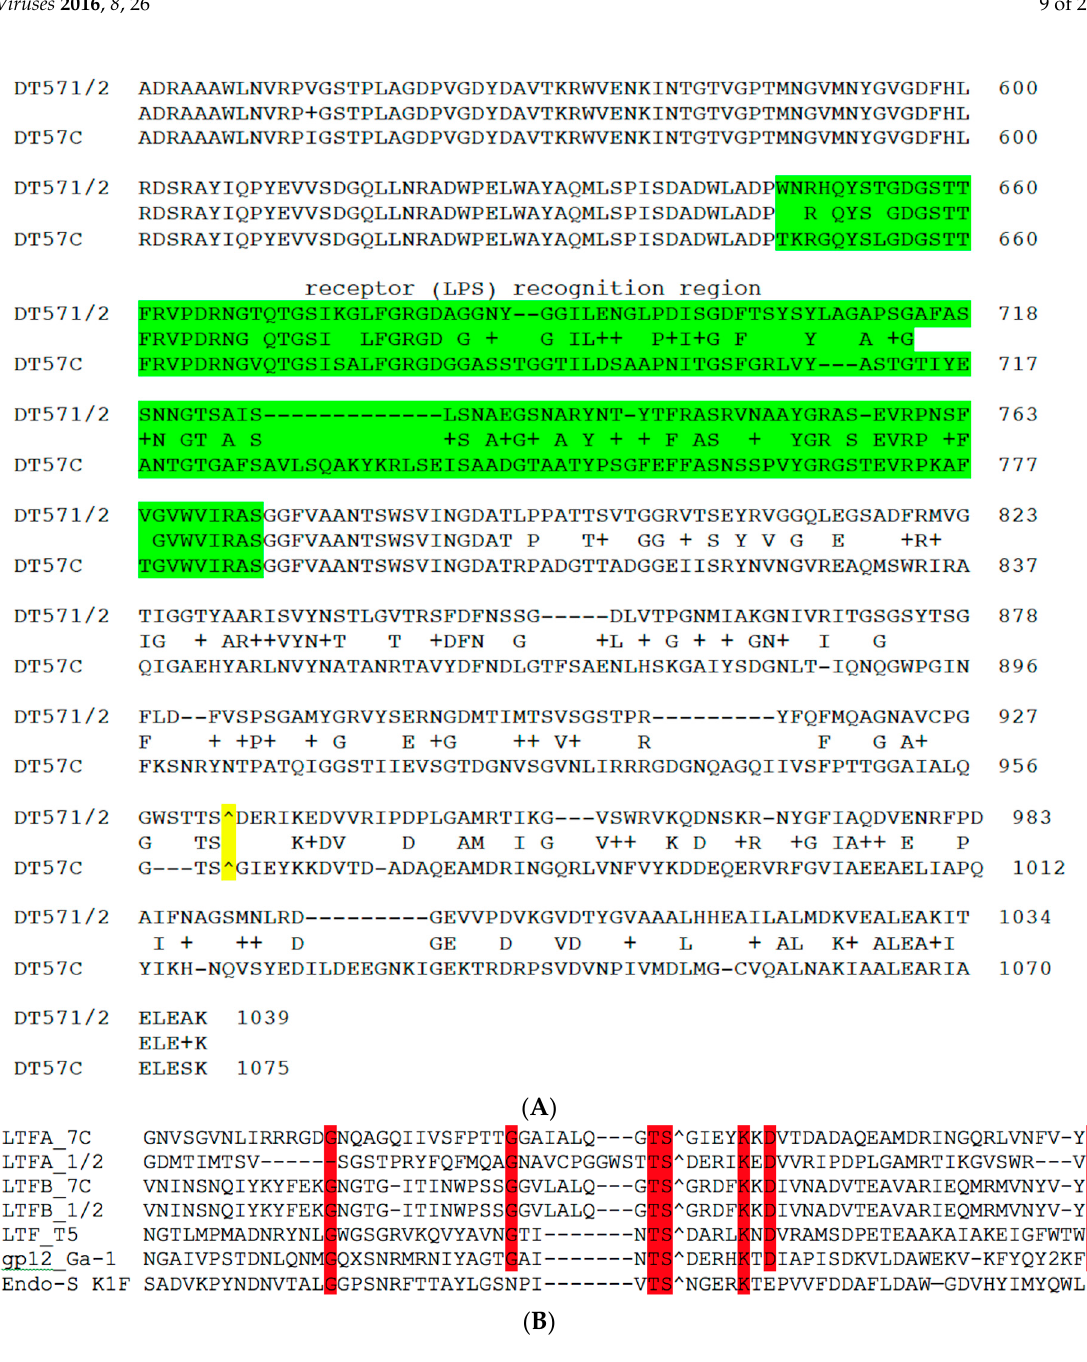
Figure 2. ( A ) BlastP alignment of the C-terminal fragments of LtfA proteins from phages DT57-1/2 and DT57C. The fragment that was transmitted by recombination with plasmids (see explanations in the text) to switch host specificity is highlighted in green. The predicted autocleavage site is marked by “^” and highlighted in yellow; ( B ) ClustalV alignment of the regions neighboring the putative cleavage site of the LtfA and LtfB proteins of our phages and in proteins with known structures of the autocleavable C-terminal chaperone domain: Ltf of bacteriophage T5 (X69460), gp12 of Bacillus subtilis bacteriophage Ga-1 (NC_002649) and endo-sialidase of E. coli bacteriophage K1F (AJ505988). “^” indicates the predicted or experimentally determined autocleavage sites. Red highlight indicates the residues conserved in six or more out of seven aligned sequences.